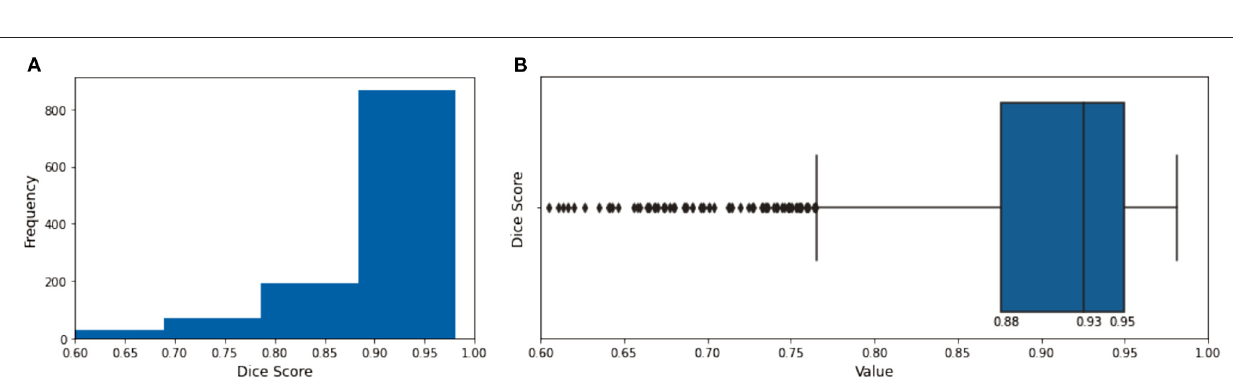
value of 0.47 for Figure 7C , and between − 16.89 and + 15.71